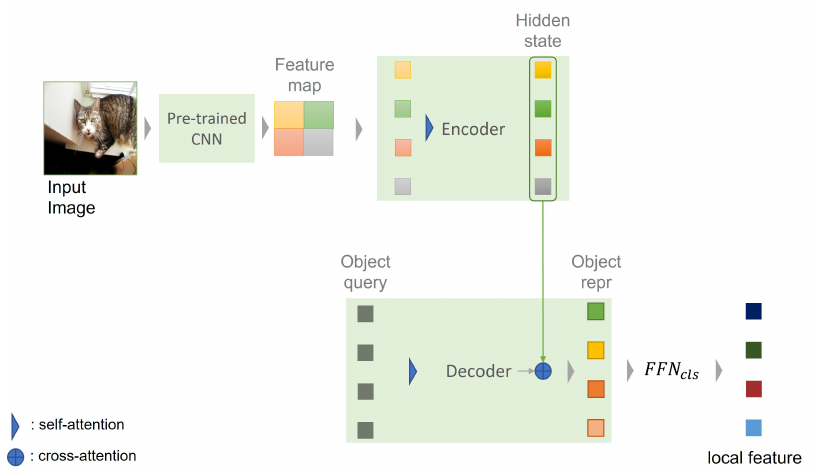
Figure 4. The pipeline of object-level feature